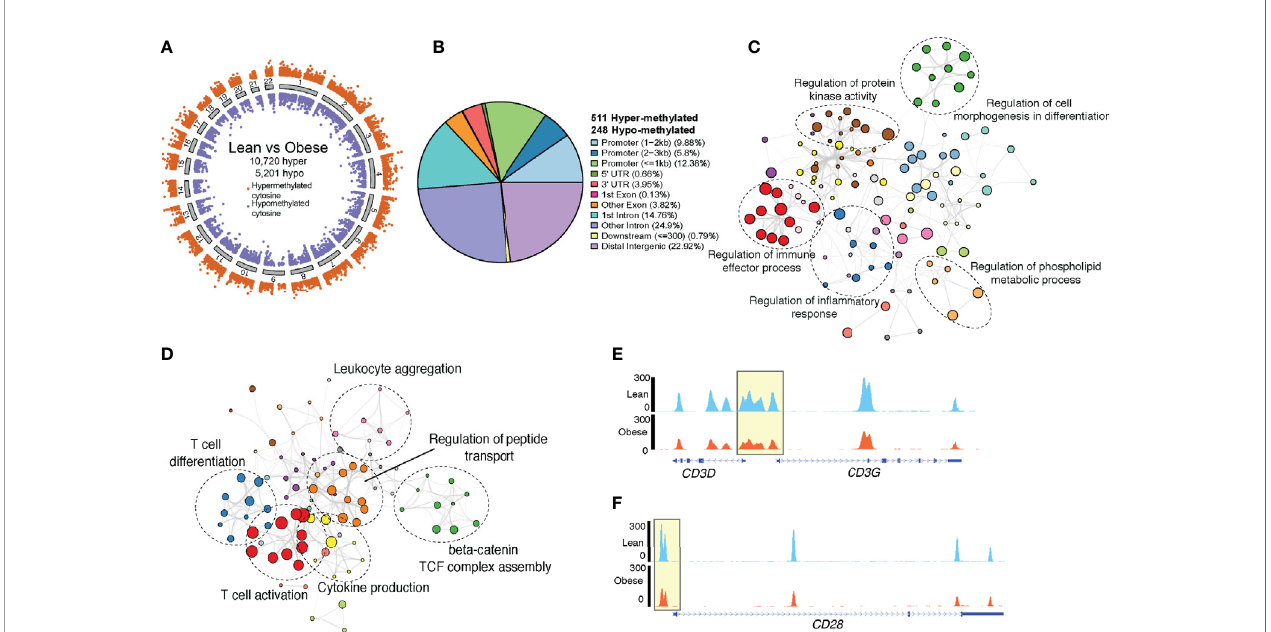
FIGURE 5 | Genome wide methylation changes in UCB CD4+ T cells. (A) Ideogram of single base resolution differentially methylated cytosine (DMC) in T cells from obese group relative to lean group (n= 6 lean, 4 obese). Each dot represents a DMC colored by direction of methylation change (orange – hypermethylated in obese vs purple – hypomethylated in obese) and clustered by chromosomes. (B) Pie chart showing genomic contexts of differentially methylated loci identi fi ed in cord blood CD4 T cells from obese group relative to lean group. (C) Network denoting functional enrichment of genes associated with hypermethylated loci in obese group relative to lean group identi fi ed by Metascape. (D) Network of functional enrichment of genes associated with hypomethylated loci in obese group relative to lean group identi fi ed by Metascape. In both networks, dashed ellipse represents a theme of highly related GO terms with individual GO terms as colored bubbles. Size of the bubbles represents the numbers of genes mapped to the term. (E) Pileups showing methylation levels of CD3 and (F) CD28 loci in lean (top panel, blue) and obese (lower panel, orange)